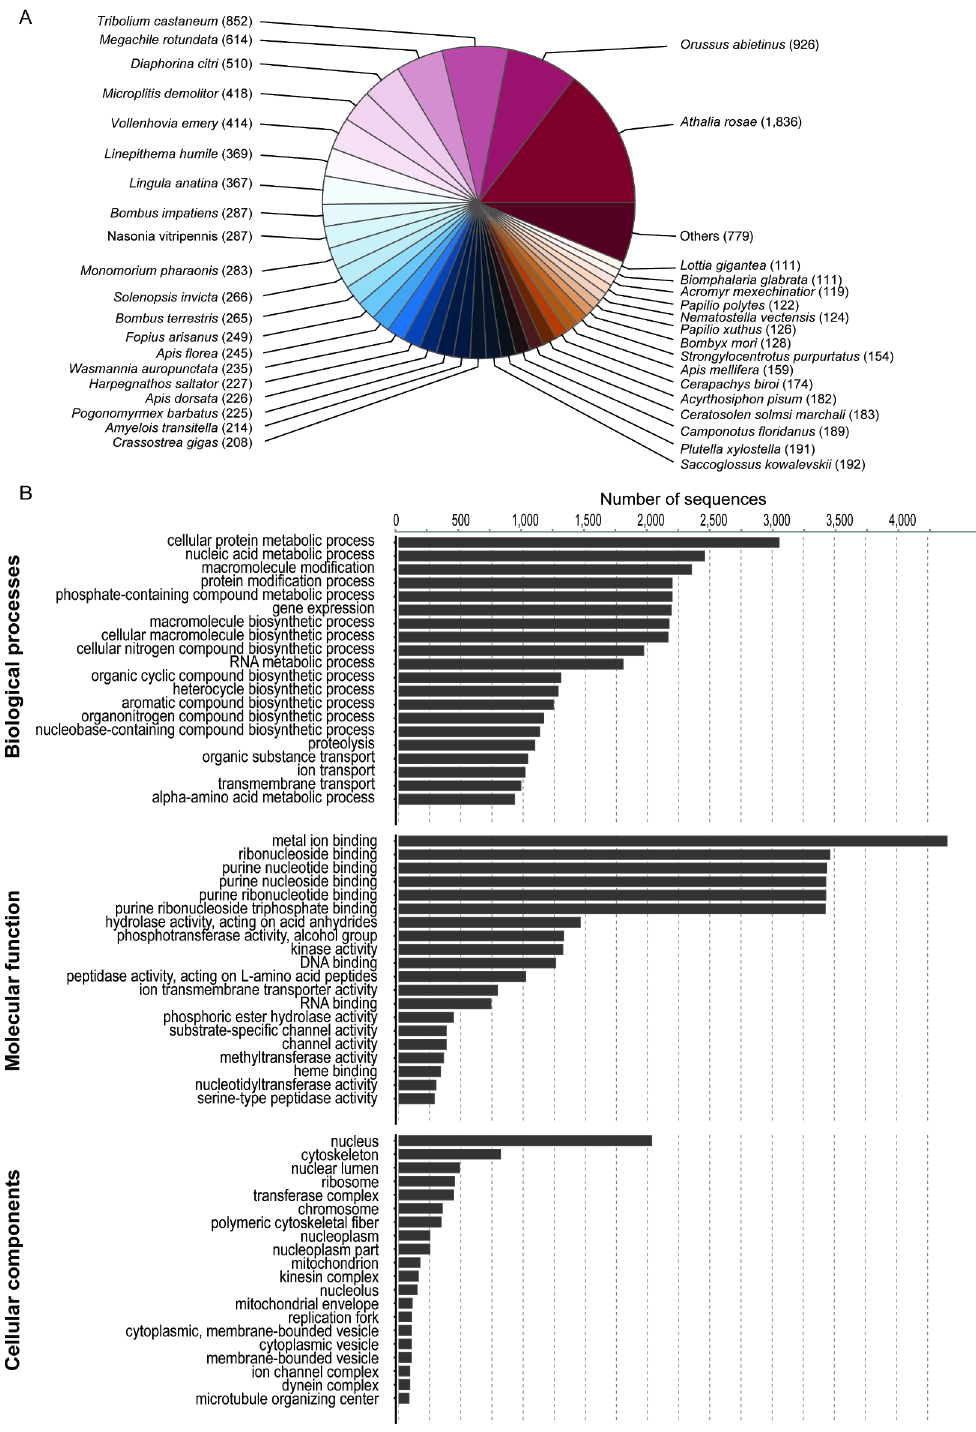
Fig 2. Functional annotation of the M . caerulatus transcriptome. A) Distributionof top hits shows all species to which M . caerulatus had at least 100 hits to. B) Classification of the functionalannotation into the three gene ontology (GO) categories: molecularfunction (MF), cellularcomponent(CC), and biologicalprocess (BP) at GO level 5. Displayedare the distribution of the top 20 GO terms and the number of sequenceswith the corresponding